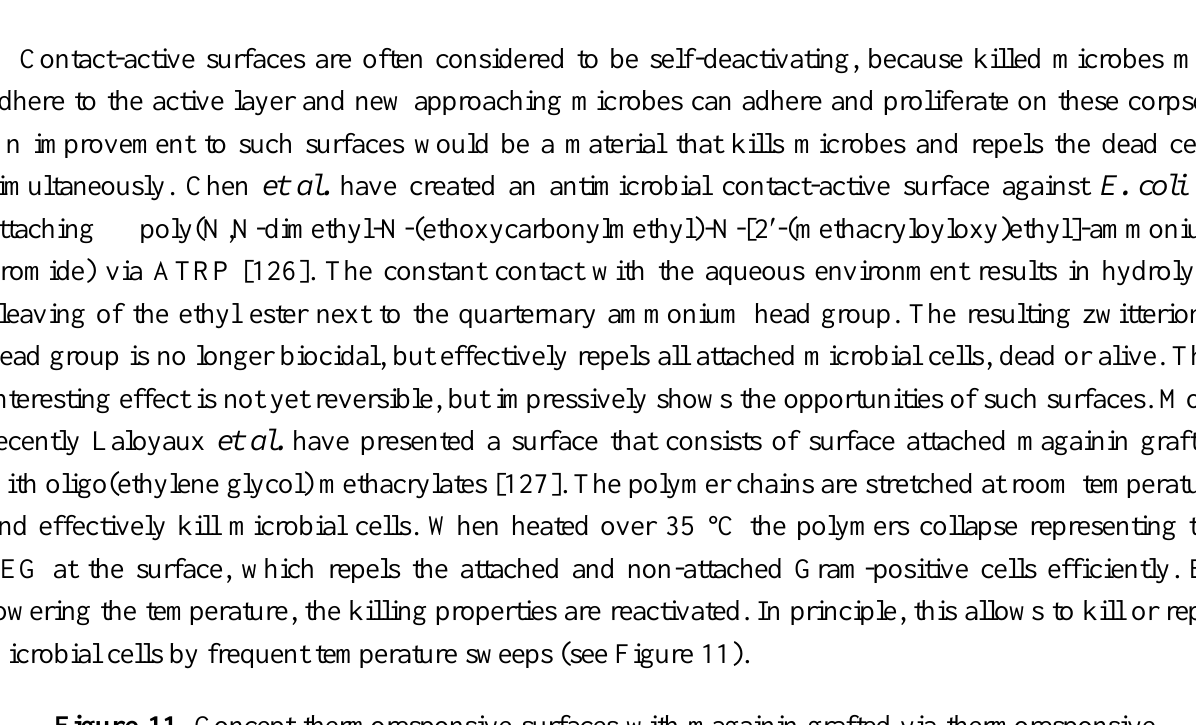
Figure 11. Concept thermoresponsive surfaces with magainin grafted via thermoresponsive oligo(ethylene glycol) methacrylates that ( a ) kill bacterial cells below and ( b ) repel them above the transition temperature. Created according to